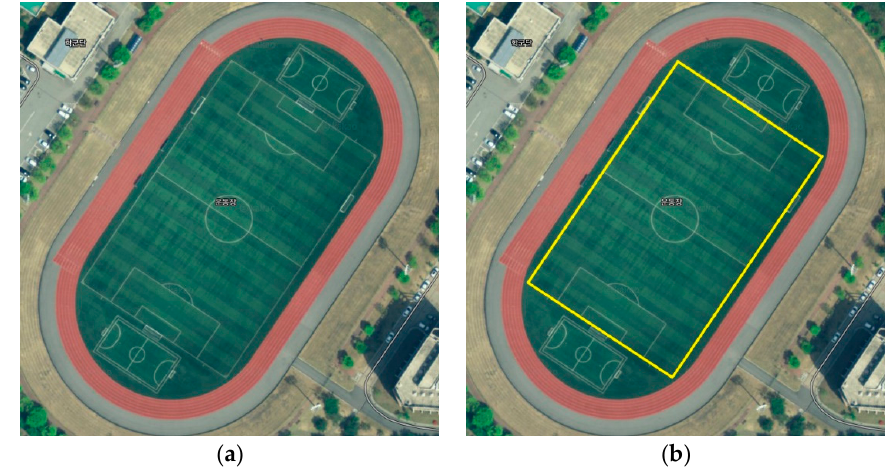
Figure 4. The experiment ground. ( a ) Konkuk University playground with 2.6-ha area. ( b ) Line tag marked zone for the experiment.